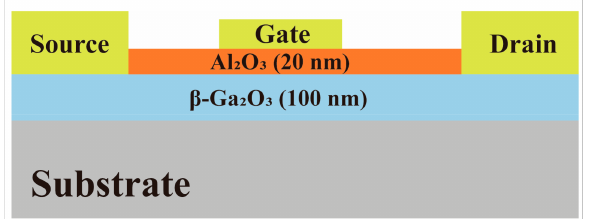
Figure 1. Cross-sectional schematic diagram of the simulated β -Ga 2 O 3 MOSFET.